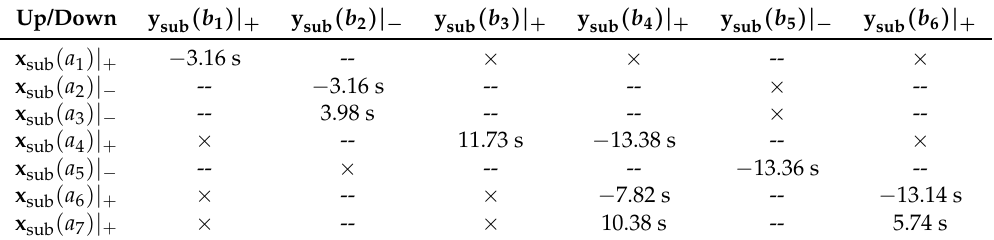
Figure 14. Abnormal sub-signals after filtering operation sub-signals. Table 1. Time difference results of cross-correlation analysis of abnormal sub-signals.